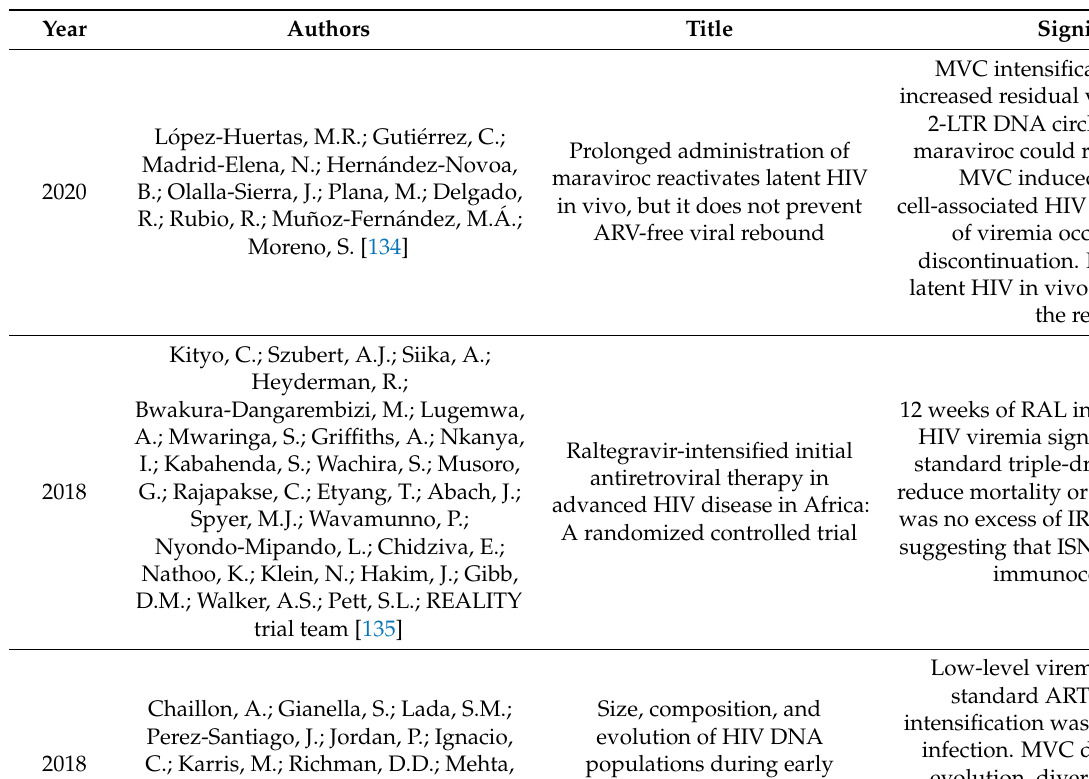
Table 2. ARV intensification studies and